Question: Briefly state, in one sentence, what is plotted here.
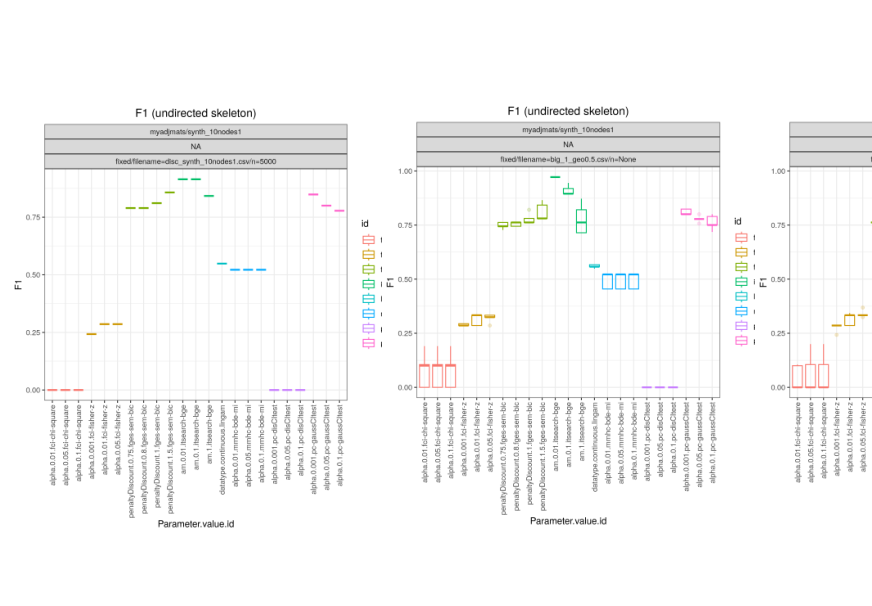
Answer: F1 Scores on the Synthetic 10 nodes data set. Discretized, no noise.